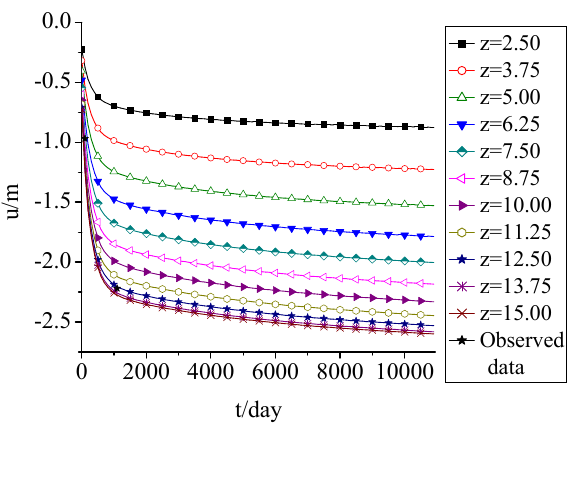
Figure 2. Displacement change with